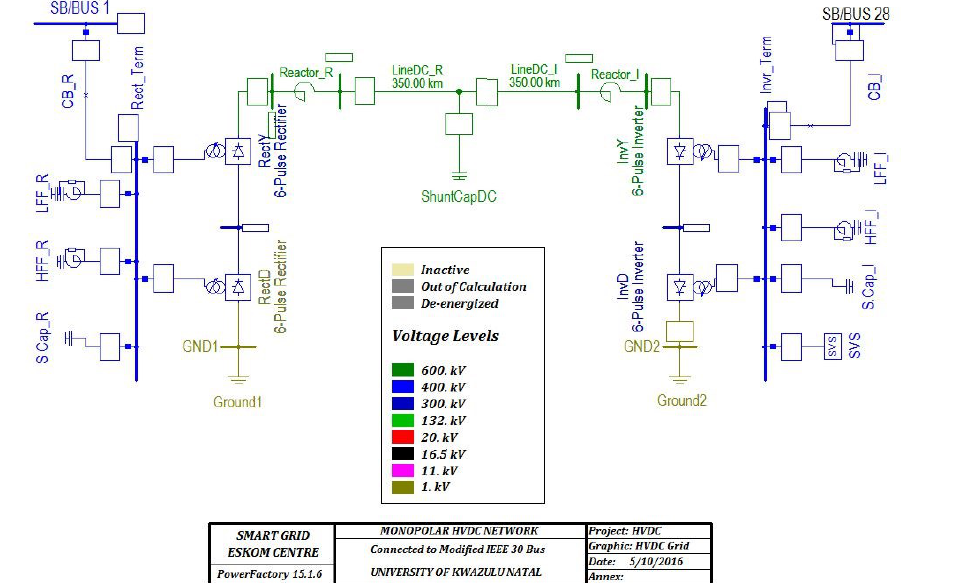
Fig. 2. Single line diagram of the modified IEEE 30 bus system.